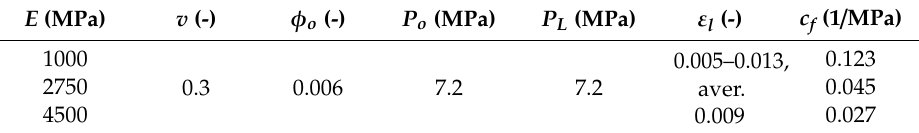
Table 3. Cretaceous Mesaverde Group, Western Canada [3,20].